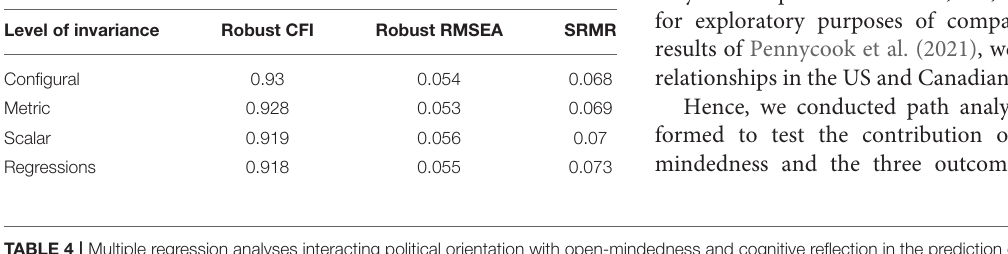
TABLE 4 | Multiple regression analyses interacting political orientation with open-mindedness and cognitive reflection in the prediction of our three dependent variables ( N =